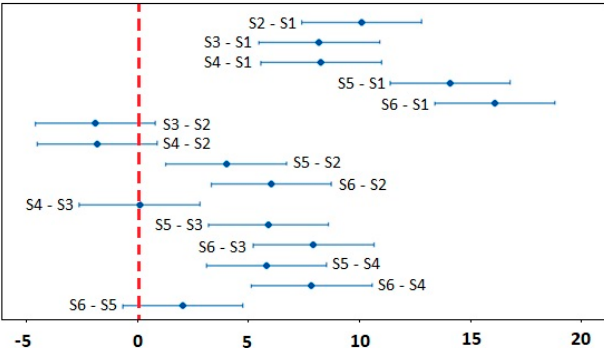
Figure 9. Tukey pairwise comparison test or oxygen content in the machined surface S1–S6.